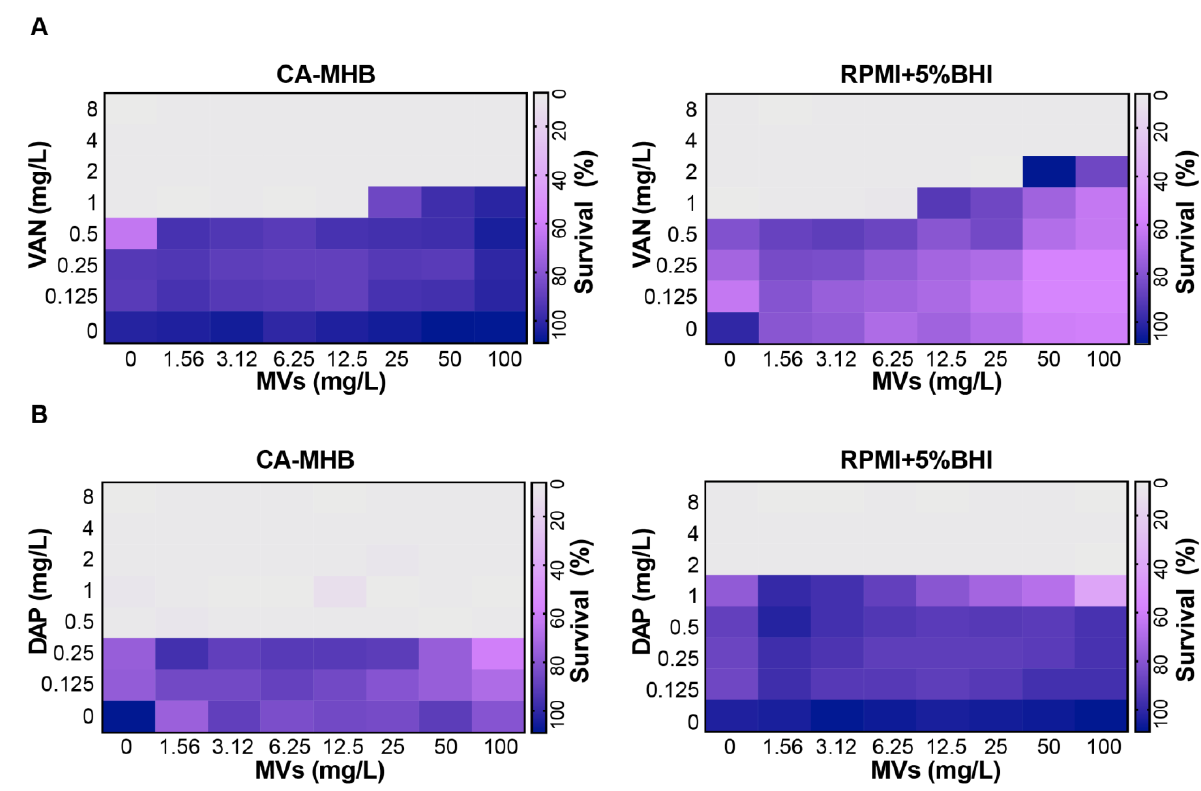
Figure 1. MVs potentiate MRSA survival in the presence of VAN. Antimicrobial susceptibility of MRSA to ( A ) VAN or ( B ) DAP in combination with MVs was assessed by checkerboard broth microdilution assays performed in CA-MHB or RPMI+5%BHI. Bacterial growth quantified by OD 600 and compared to the growth of untreated control wells was reflected as a heat map of percentage bacterial survival. Data are representative of at least two biologic replicates. CA-MHB: Cation- adjusted Mueller–Hinton Broth; RPMI+5%BHI: Roswell Park Memorial Institute 1640 + 5% Brain Heart Infusion; VAN: Vancomycin; DAP: Daptomycin; MVs: Membrane Vesicles.